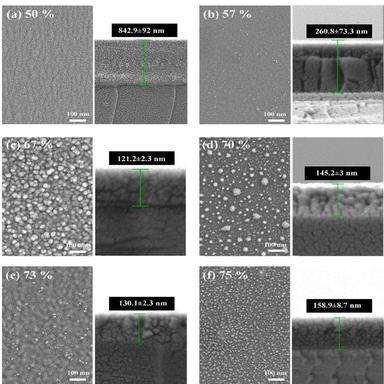
SEM images (surface and section) of chromium oxide samples under different oxygen partial pressures. Image a) displays the surface and cross-sectional morphologies at 50 % oxygen partial pressure. Images b) through f) sequentially depict the changes in both surface and cross-sectional morphologies at oxygen partial pressures of 57 %, 67 %, 70 %, 73 %, and 75 %, respectively.